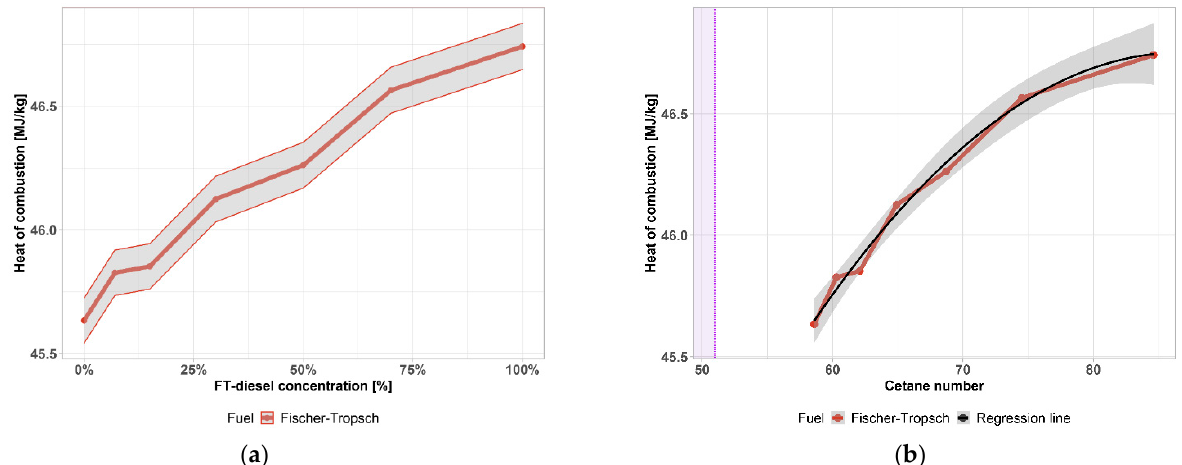
Figure 3. ( a ) Heat of combustion of FT-diesel mixtures; ( b ) regression function of heat of combustion as a function of cetane number.